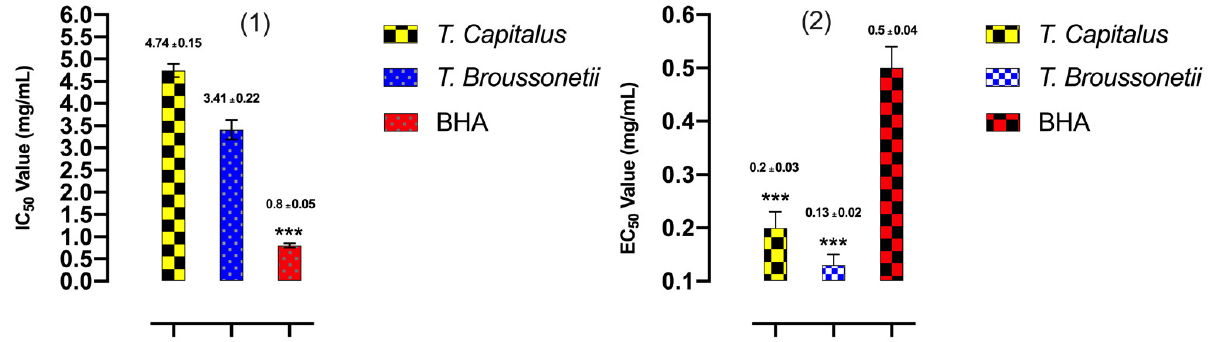
Figure 3. IC 50 and EC 50 of T. capitatus and T. broussonetii EOs and of BHA standard measured by DPPH ( 1 ) and FRAP ( 2 ) methods. Data are expressed as mean ± SD. The experiment was performed in a minimum of three replicates. *** p < 0.001 compared to the samples ( 1 ); *** p < 0.001 compared to the control BHA ( 2 ).